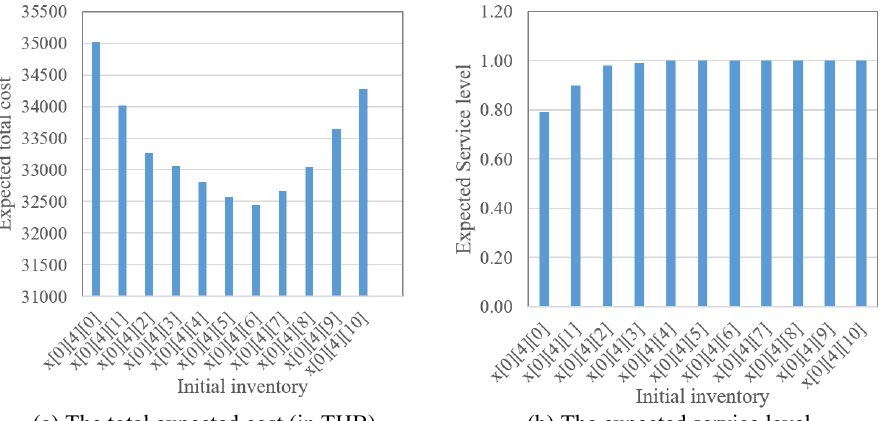
(b) The expected service level Fig. 7. Performance of the DP model by evaluating the total expected cost (in THB) and expected service level based on varying the number of initial inventories